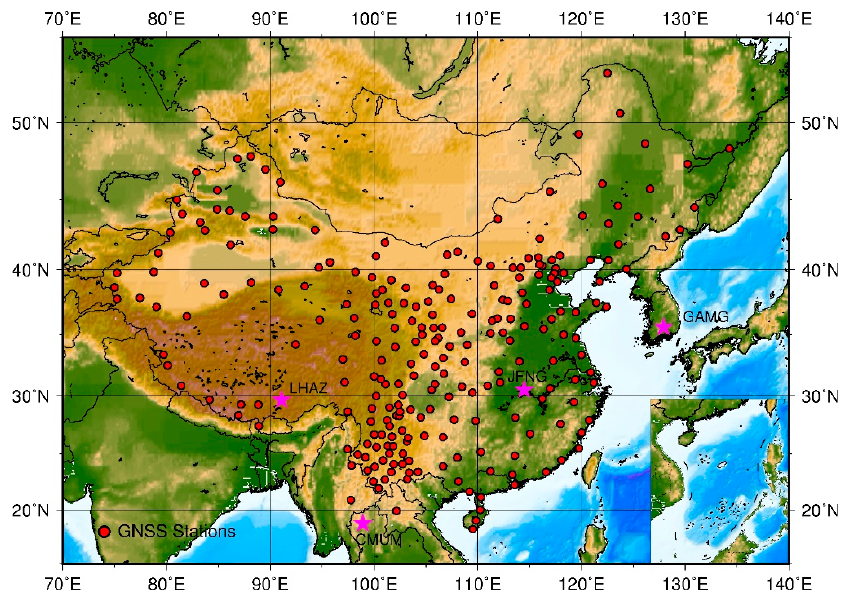
Figure 1. Geographical distributions of GNSS receivers from CMONOC (red circles) and MGEX (magenta pentagrams) networks.